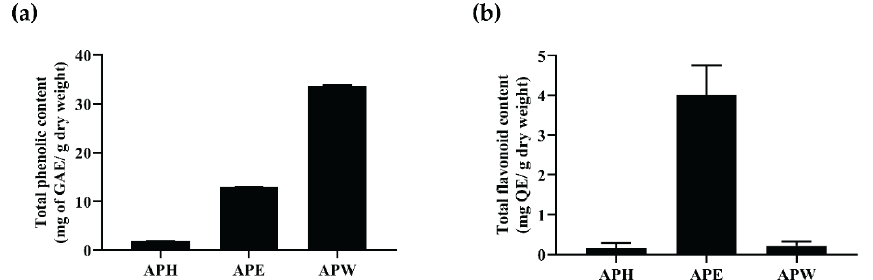
Figure 1. Total ( a ) phenolic and ( b ) flavonoid contents exist in AP crude extracts. All data are shown as the mean ± SEM of triplicate values. Table 1. Antioxidant capacity and half-maximal effective concentration (EC 50 ) of free radical scavenging activity of AP crude extracts. Crude Extract